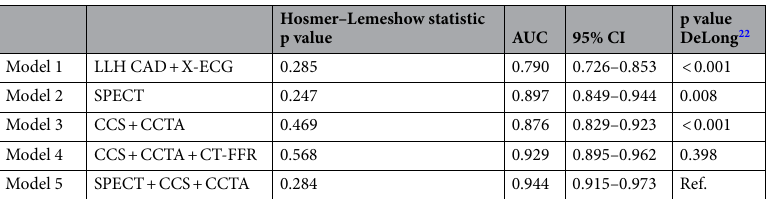
Table 3. Discrimination and calibration of the models of interest. AUC area under the curve, CAD coronary artery disease, CCS coronary calcium score, CCTA coronary computed tomography angiography, CI